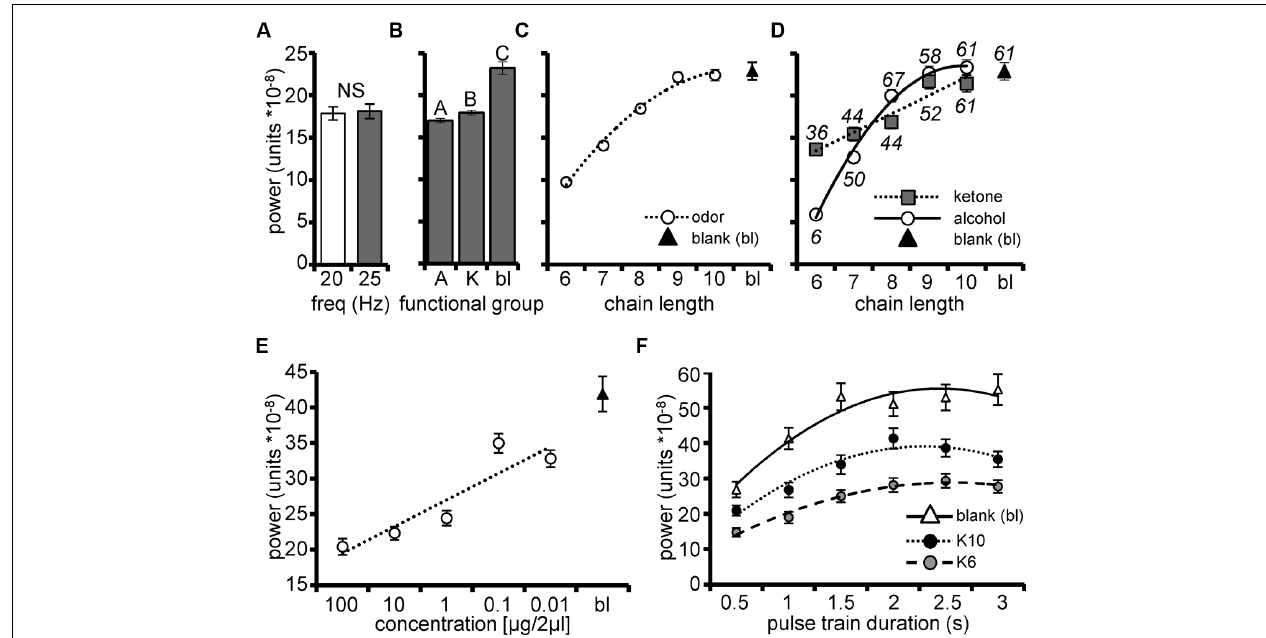
FIGURE 3 | Unitary pulse tracking is dependent on stimulus parameters. Mean integrated pulse tacking power (Y-axis) among units as a function of frequency (A) , functional group (A = alcohol, K = ketone; bl = blank; (B) , and carbon chain length (C) for pulsed stimuli. Blank responses are included as a point of reference. Inset regression line is a second order polynomial highlighting the significant trend of increasing power as a function of chain length. (D) Mean power by the significant interaction of chain length and functional group from the subpopulation of units identified as pulse tracking ( N = 36 units; 15 moths). Inset (above/below respective means) is the percentage of the pulse tracking cells that tracked a given stimulus. Inset are regression lines for ketones is a linear function and for alcohols is a second